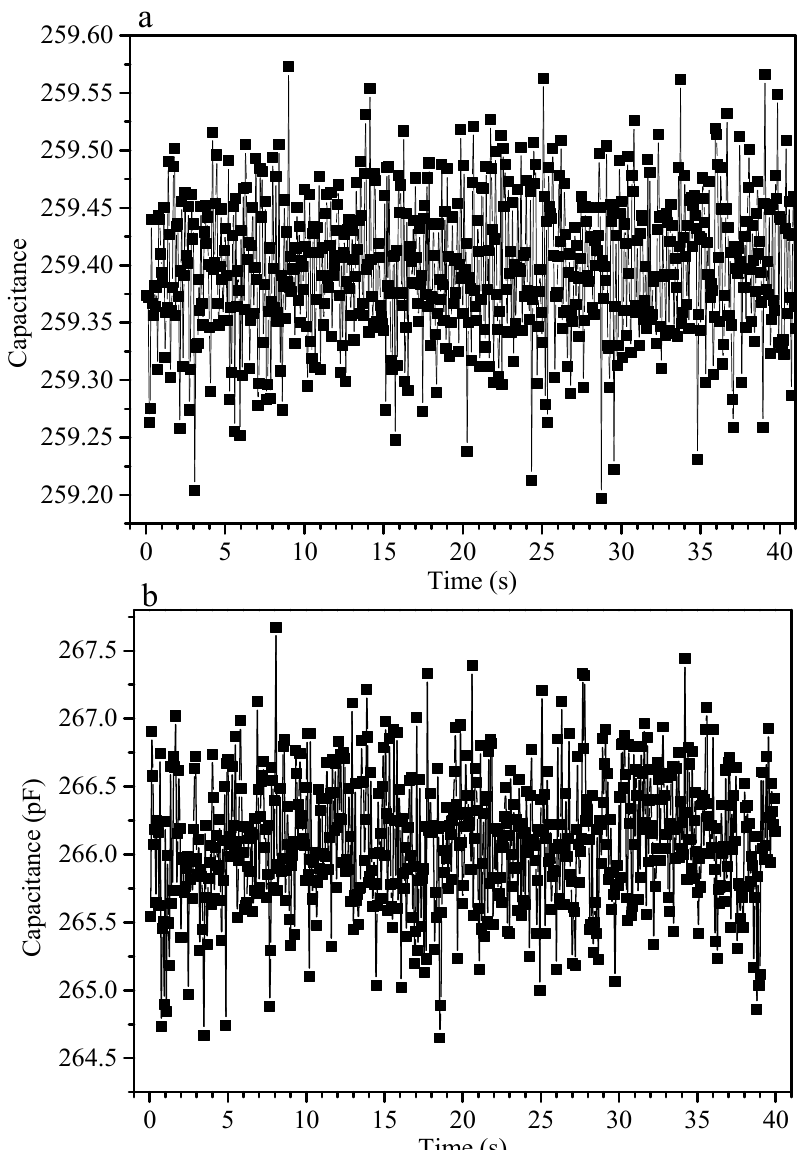
Figure 7. ( a ) Capacitance signals measured from a wearable sensor at rest on table. ( b ) Signals obtained when the wearable sensor is attached to the skin of a stationary human elbow. Measurements were made at 2.5 Hz sampling frequency.